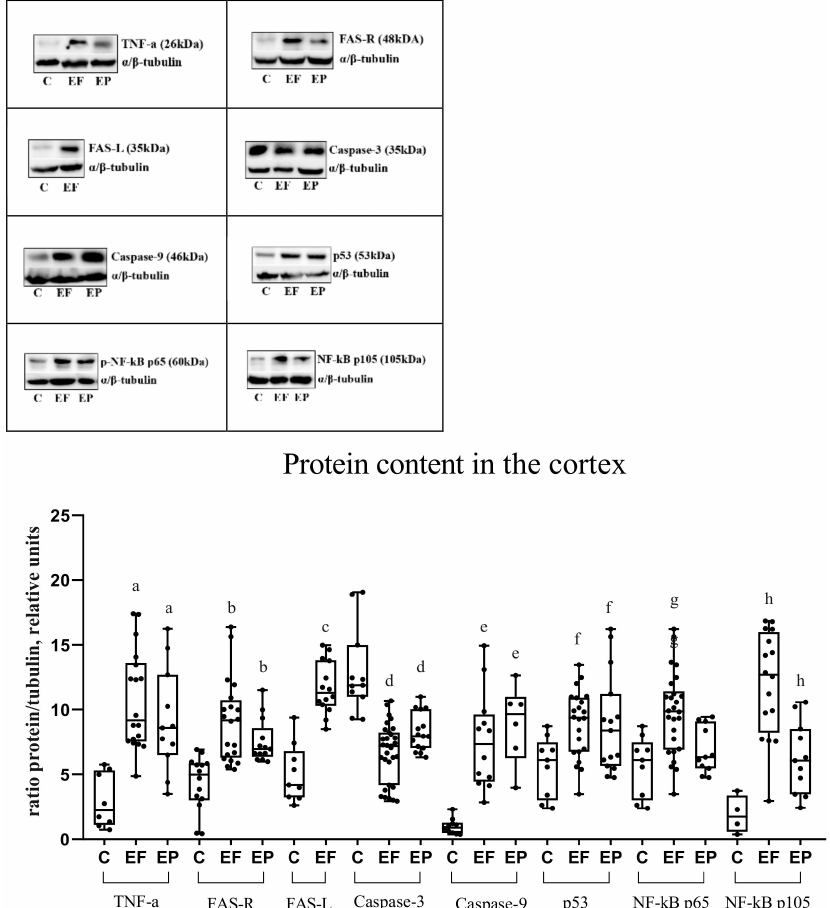
Figure 4. Content of TNF- α , FAS-R, FAS-L, caspase-3, caspase-9, p53, p-NF-kB p65, p-NF-kB p105 in the temporal lobe cortex. Lysates of biopsies of the human temporal lobe cortex were studied on a 10% polyacrylamide gel using Western blot. C, control group; EF, epileptic focus; EP, perifocal zone. Significant differences: a, differences in the content of TNF- α protein in the cortex compared to the control group, statistically significant at p < 0.05; b, differences in the content of FAS-R protein in the cortex in comparison with the control group, statistically significant at p < 0.05; c, differences in the content of FAS-L protein in the cortex compared to the control group, statistically significant at p < 0.05; d, differences in the content of caspase-3 protein in the cortex compared with the control group, statistically significant at p < 0.05; e, differences in the content of caspase-9 protein in the cortex compared to the control group, statistically significant at p < 0.05; f, differences in the content of p53 protein in the cortex in comparison with the control group, statistically significant at p < 0.05; g, differences in the content of p-NF-kB p65 protein in the cortex compared to the control group, statistically significant at p < 0.05; h, differences in the content of NF-kB p105 protein in the cortex compared to the control group, statistically significant at p <